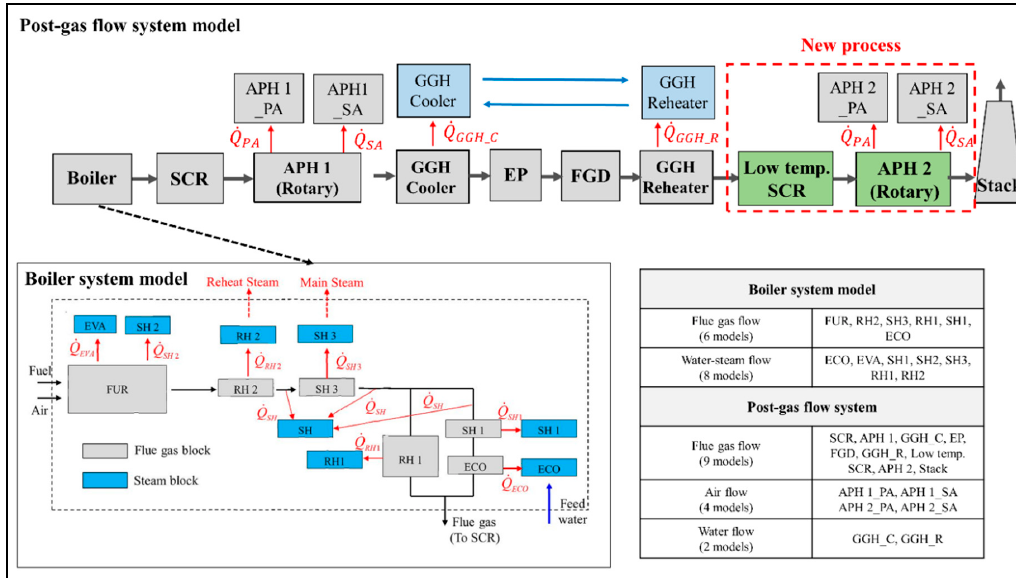
Figure 6. Process simulation model outline of previous and new processes in the target power plant (including post-gas flow and boiler system